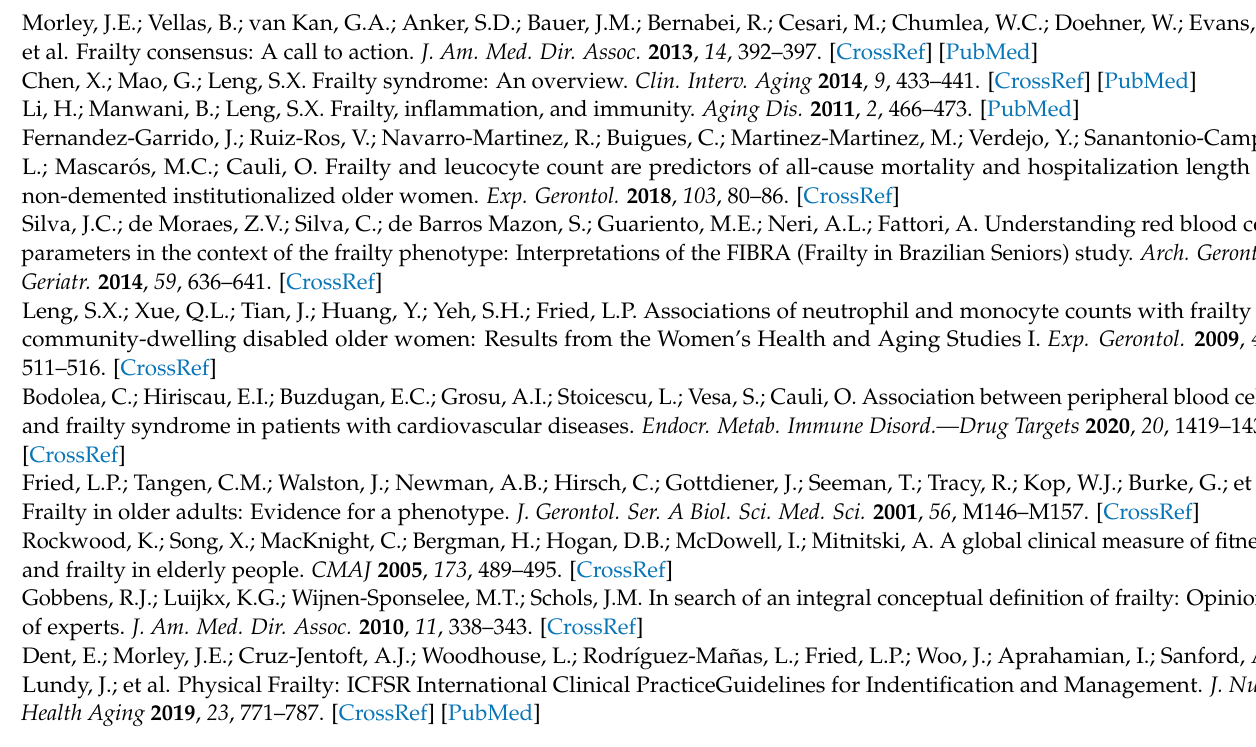
Table S9: Correlations between Duke Activity Status Index (DASI) and Quality of life (QoL) domains in frail middle-aged subgroup at baseline and